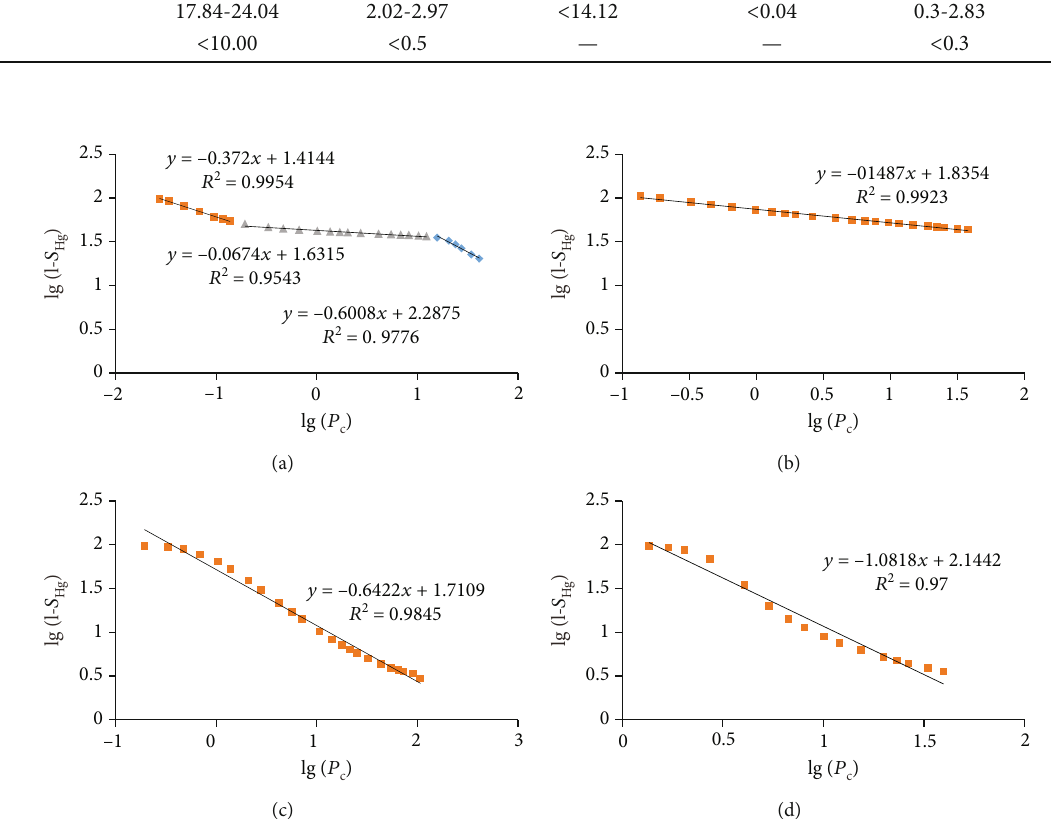
‐ lg P based on MICP data: (a) type I (well H2, 2464.63m, Kh Hg c ); (d) type IV (well B1, 2669.36, Kh 2